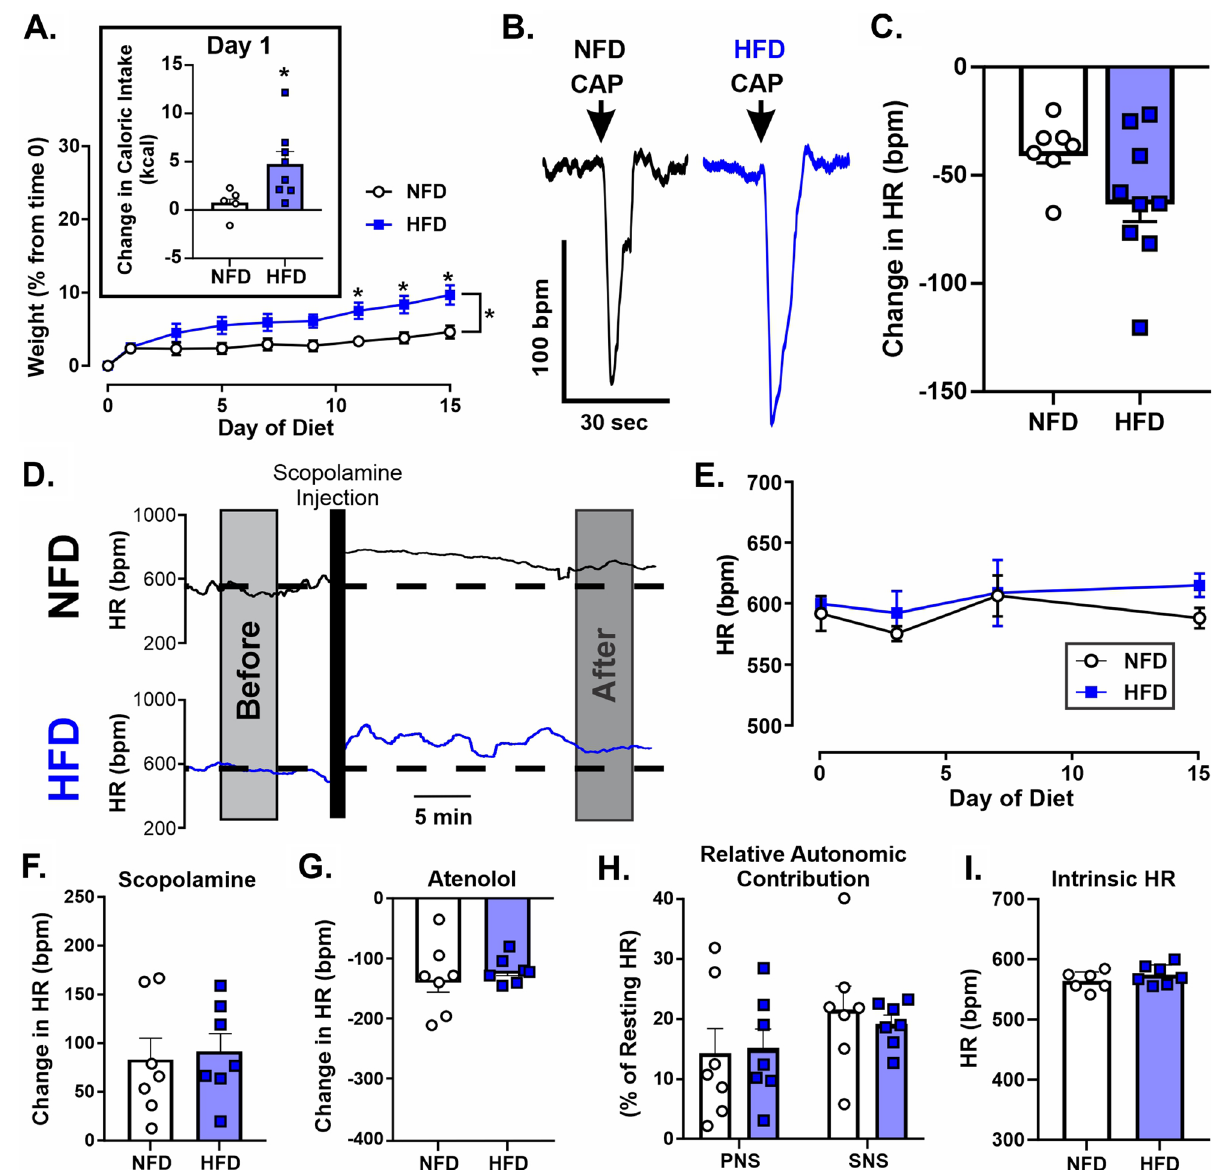
Figure 5. ChAT-δ null mice were not significantly different then NFD controls after 15 days of HFD. HFD increased percent body weight over time and Day 1 food intake in ChAT-δ null mice (n = 8) compared to NFD (n = 7) ( A ). Representative HR trace of capsaicin-induced cardiopulmonary chemoreflex response on Day 15 of either NFD or HFD ( B ). Mean HR change to cardiopulmonary chemoreflex was not significantly different between HFD (n = 9) and NFD (n = 7) in ChAT-δ null mice ( C ). Representative HR trace from awake ChAT-δ null mice on day 15 (D). Quiet resting HR over time ( E ), and response to methylscopolamine ( F ) and atenolol ( G ), were not different between ChAT-δ null mice on HFD (n = 7) and NFD (n = 7). Autonomic contribution to resting HR ( H ) and intrinsic HR ( I ) were also not different in ChAT-δ null mice on HFD ( E ) compared to ChAT-δ null mice on NFD. * denotes significant difference between